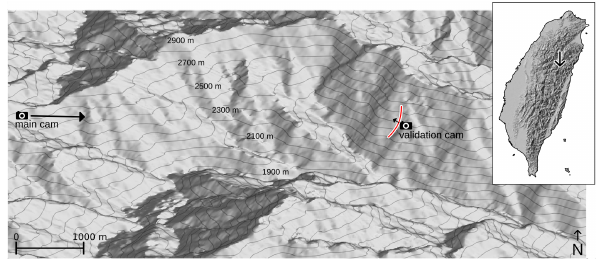
Figure 2. Isometric view of the western end of the Taroko Gorge with the positions of the cameras. The black arrows denote the cam- eras’ viewing directions. The red line marks a small recess in the slope. The location of the area in Taiwan is marked in the upper right overview map.